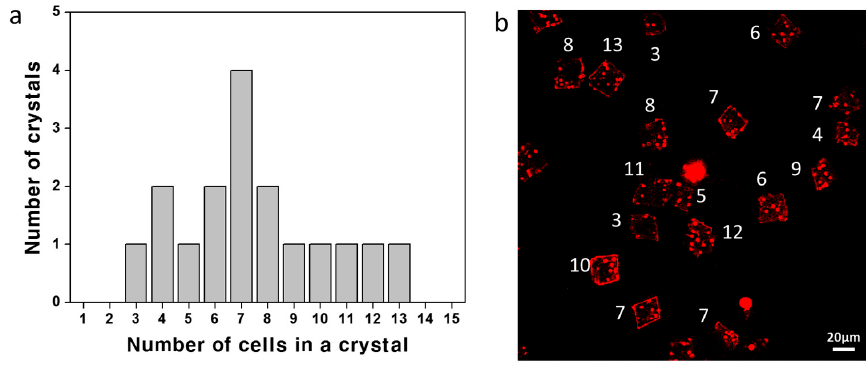
Figure 8. ( a ) The distribution of the cell number in a crystal (1.4 mg/mL cell and 50 mM CaCl 2 /Na 2 CO 3 ) and ( b ) the corresponding confocal microscope image obtained by merging 15 depth-scanned images of red fluorescence (the white number indicating the cell counts). The average number of cells in a crystal is 7.47.